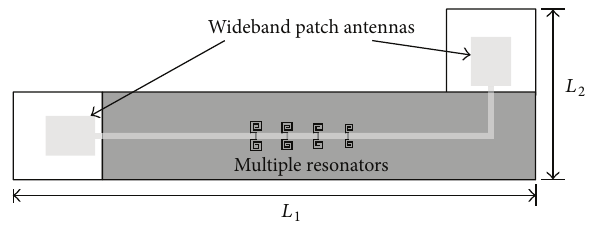
Figure 6: Layout of the microwave tag system (on the thin substrate).